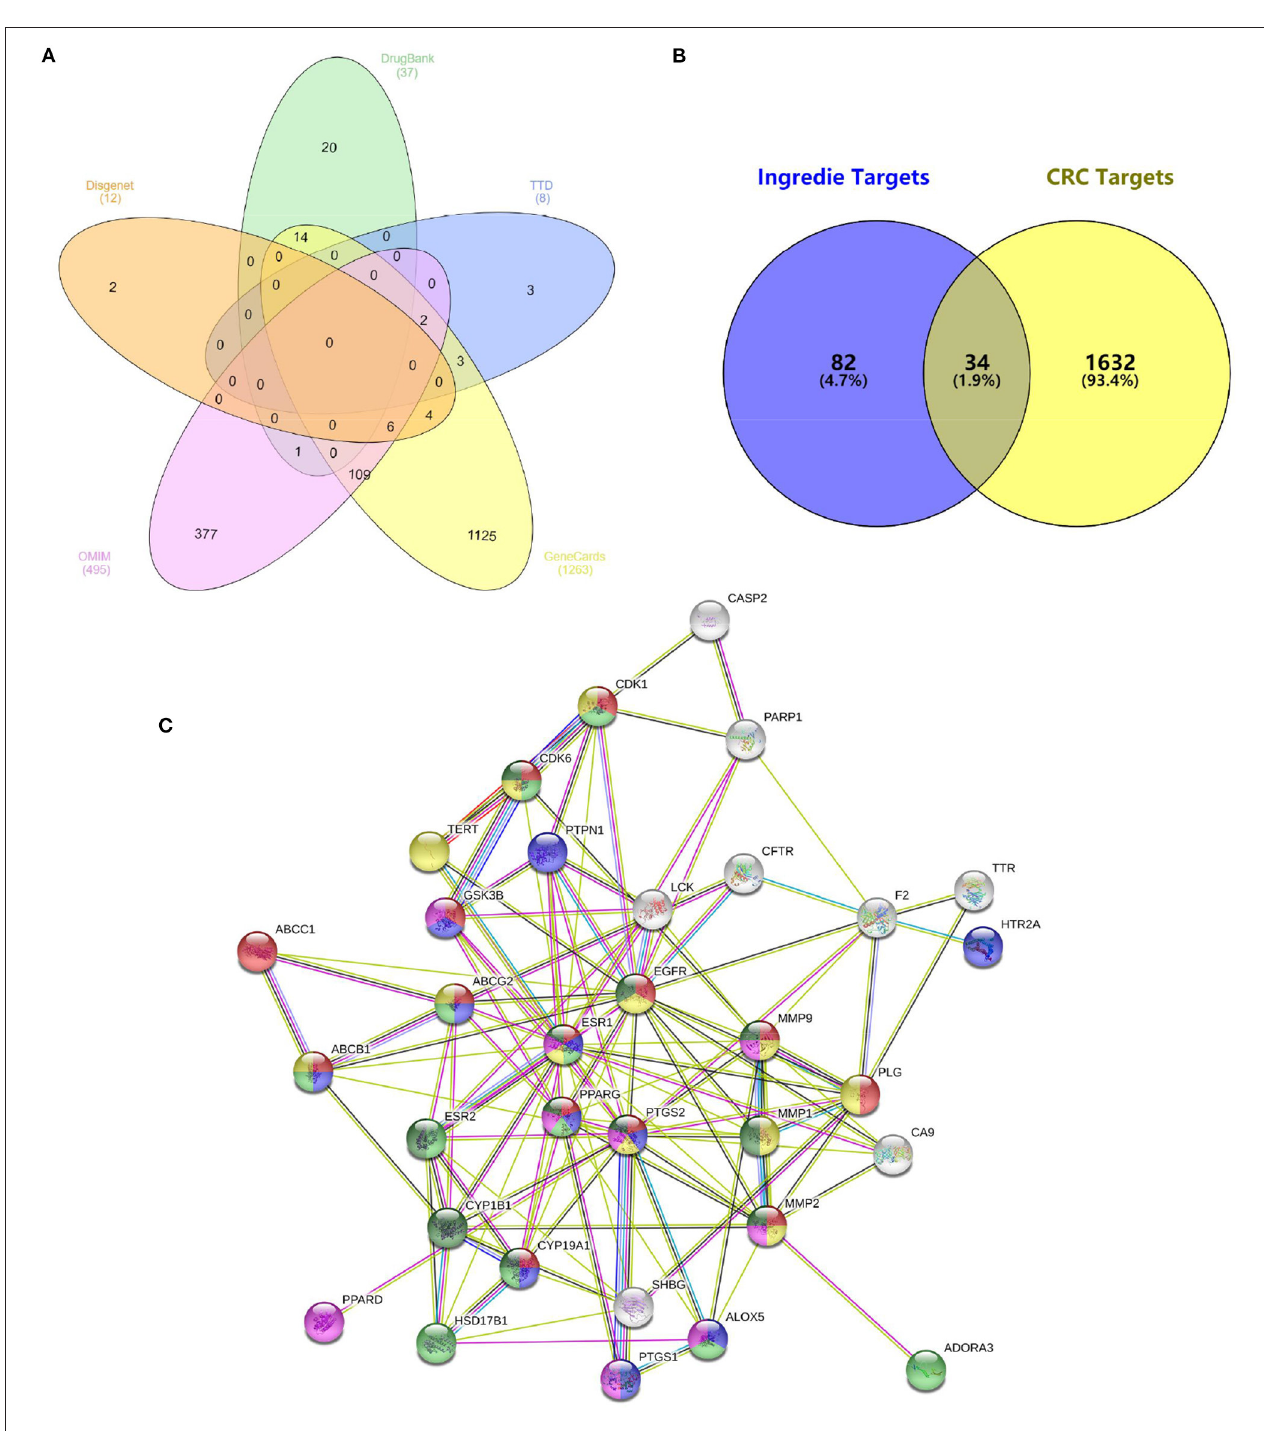
FIGURE 2 | (A) 1,666 colon cancer-related targets. (B) Overlapping targets of active component targets and CRC targets. (C) Protein–protein interaction (PPI) network analysis.